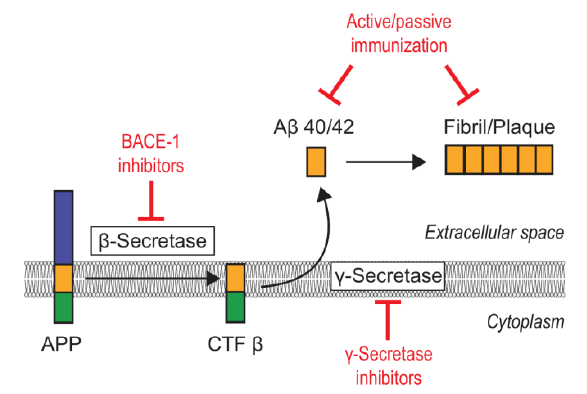
FIGURE 3: Current treatment strategies based on the amyloid cascade hypothesis. Recent or ongoing clinical trials have mainly focused on inhibition of β-secretase (BACE-1), γ-secretase, or immunization strategies against Aβ monomers or plaques. See text for details. CTFβ, C-terminal fragment